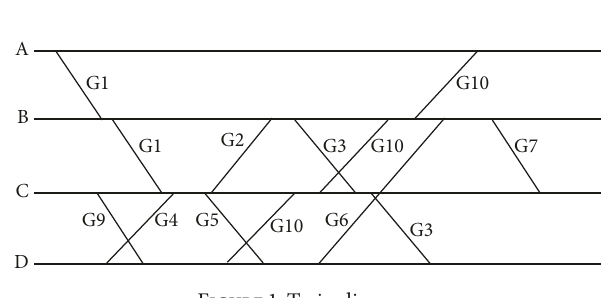
Figure 1: Train diagram.